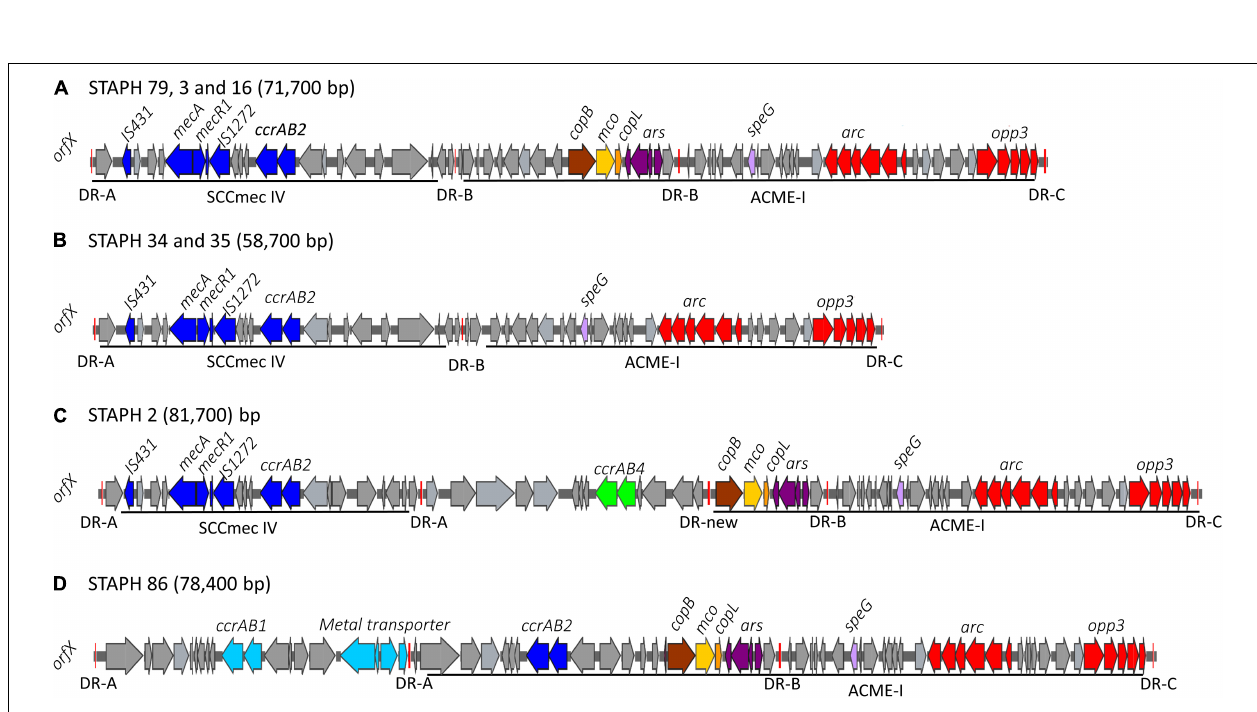
FIGURE 2 | Schematic map of the COMER-like elements in S. epidermidis . The COMER element previously described in MRSA USA300 strain CA12 (GenBank accession number CP007672) (A) and the SCCmec-III element previously described in strain 85/2082 (GenBank accession number AB037671) (C) are included for comparison. Characteristic genes of the COMER-like element are colored including the mer operon, the abi genes, and the restriction modification system (green), the cop operon (yellow-brown) and ars operon (purple). The SCC mec element genes colored include the mecA, ccrAB3 genes (blue), and the cad operon (light green). An additional module harboring a metal transporter, ccrAB4 (bright green) and speG genes (light purple) is found upstream SCC mec- III in our S. epidermidis strains (B) . Homologous regions between the different elements are shown by shading. The direct repeats (DR) are indicated.